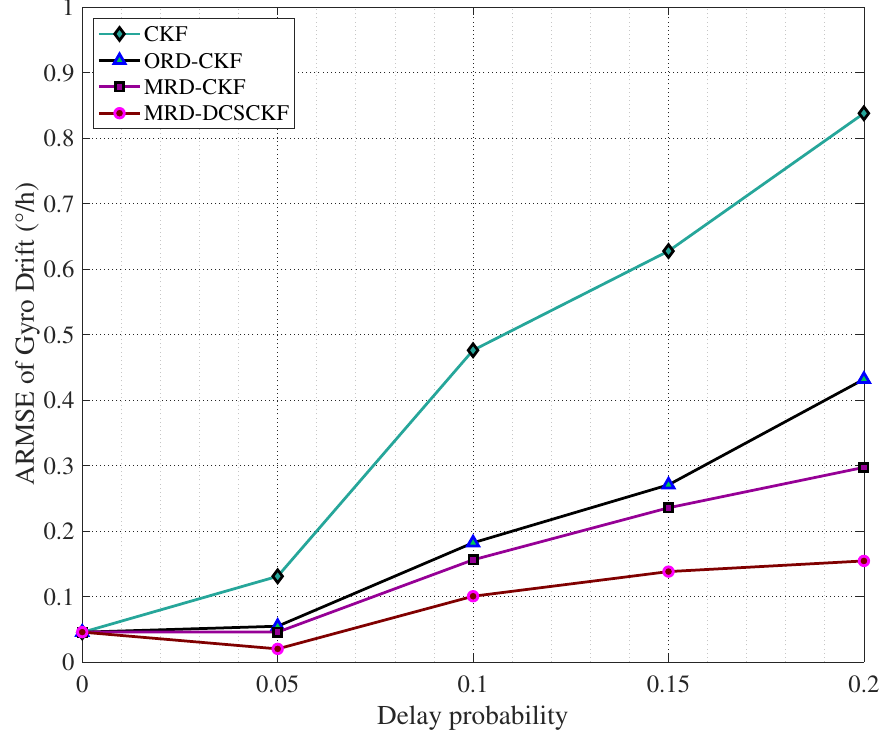
Figure 19. ARMSEs of gyro drift under different delay